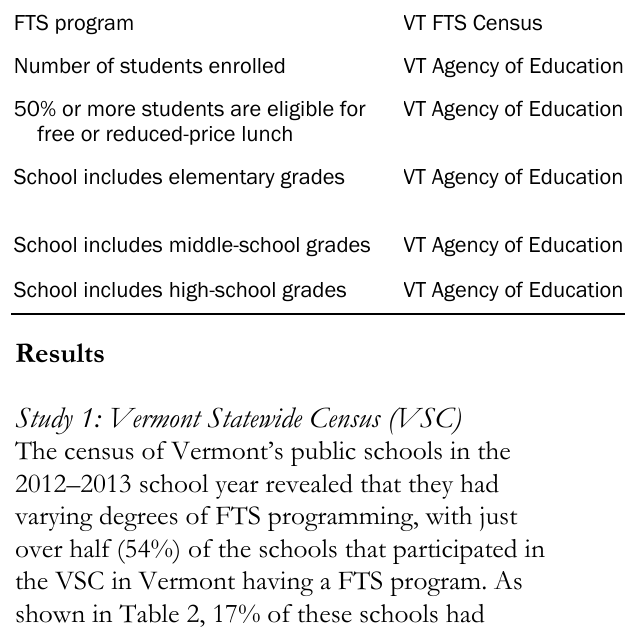
Table 3. Schools Receiving a State FTS Grant Compared